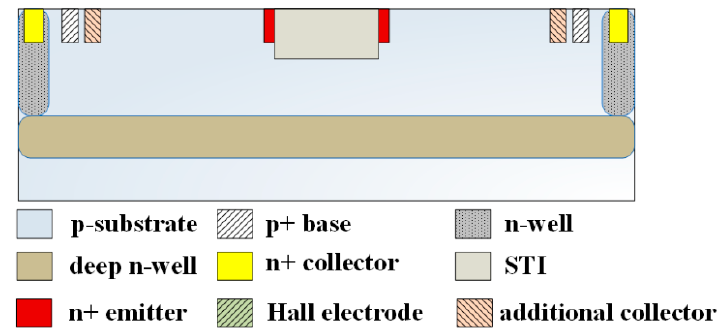
Figure 6. Cross-sectional view of the MMF sensor after the CMOS process. Figure 6. Cross ‐ sectional view of the MMF sensor after the CMOS process. Figure 6. Cross ‐ sectional view of the MMF sensor after the CMOS process.